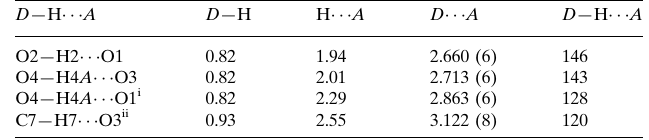
Hydrogen-bond geometry (A˚ , (cid:2)